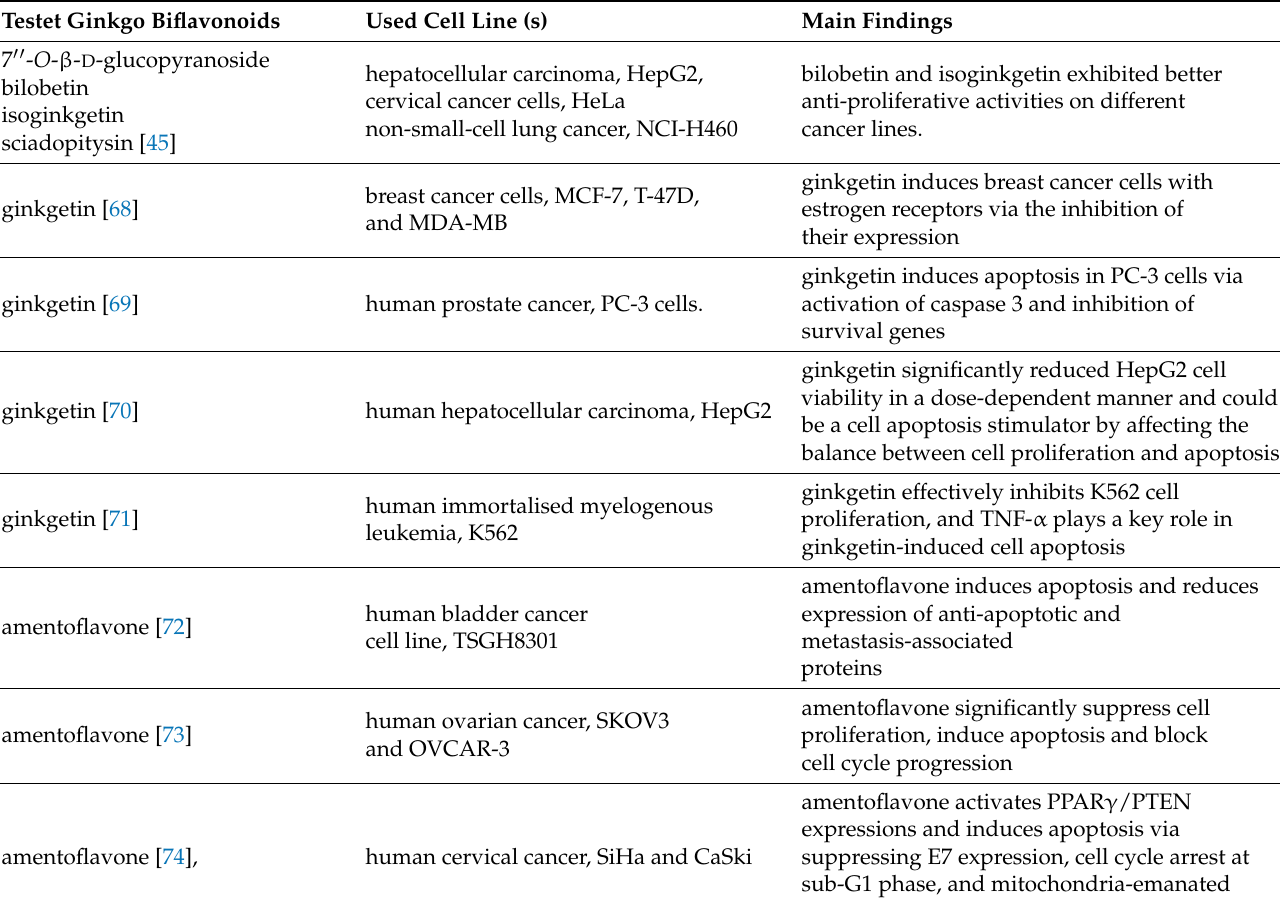
Table 4. Results of in vitro studies on cell lines using ginkgo biflavonoids. Testet Ginkgo Biflavonoids Used Cell Line (s) Main Findings bilobetin and isoginkgetin exhibited better anti-proliferative activities on different cancer